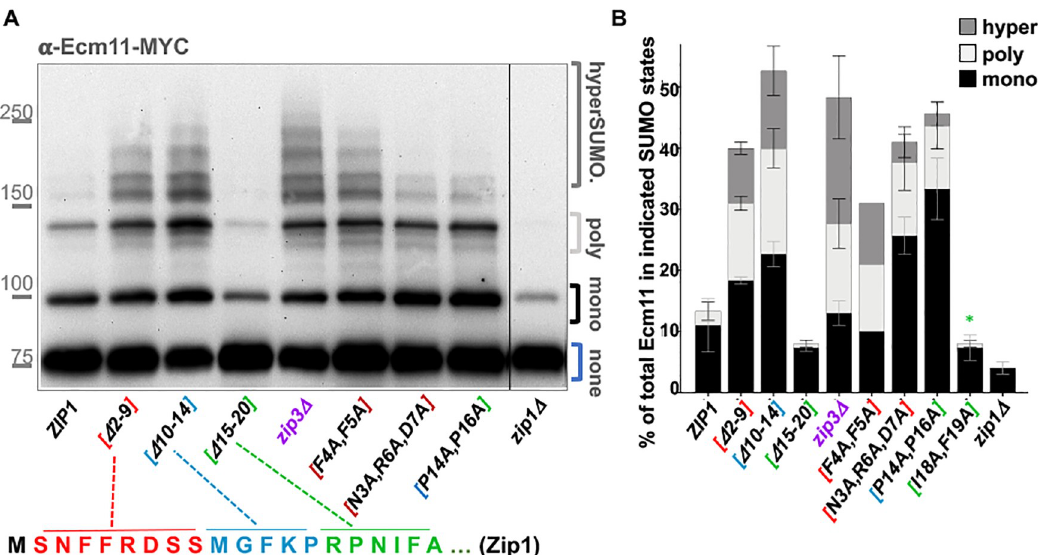
Fig 8. Zip1 residues 15–20 promote, while residues 2–14 limit, SUMOylation of the SC central element protein Ecm11. A) A representative Western blot using an anti-MYC antibody reveals unSUMOylated, mono-SUMOylated, poly-SUMOylated and hyper-SUMOylated forms of Ecm11-MYC in meiotic extracts prepared from ZIP1 ZIP3 , zip3 , or various zip1 mutant strains (protein alterations caused by each zip1 allele is indicated on the x axis). All strains carry an ndt80 null allele, which causes a meiotic arrest that ensures maximal enrichment of mid-meiotic prophase stage cells at 24 hours after placement into sporulation medium [44]. Meiotic extracts were prepared at 24 hours after placement into sporulation media, as previously described [13, 38]. Strains included in this analysis are: AM2712 ( ZIP1 ), MP39 ( zip1[ Δ 2–9]) , SYC96 ( zip1[ Δ 10–14]) , SYC97 ( zip1[ Δ 15–20]) , AM3719 ( zip3) , AM3662 ( zip1[F4A , F5A]) , AM3628 ( zip1[N3A , R6A , D7A]) ,AM3656 ( zip1[P14A , P16A]) , AM2784 ( zip1 Δ ) , K986 ( zip1[I18A , F19A]) . B) The stacked bar graph plots the percentage of mono-SUMOylated (dark shaded bar), poly-SUMOylated (light bar), or hyper- SUMOylated (gray shaded bar) forms of Ecm11-MYC detected in each strain at 24 hours after placement into sporulation media. The absence of a light or gray bar in some strains indicates that this form of Ecm11 was detected in less than 1% of the total population. Error bars represent the range of values from three independent meiotic cultures, except in the case of the zip1[F4A , F5A] strain, where only one experiment was performed. Data plotted is listed in S6 Table. � Note zip1[I18A , F19A] is not present in the blot shown in